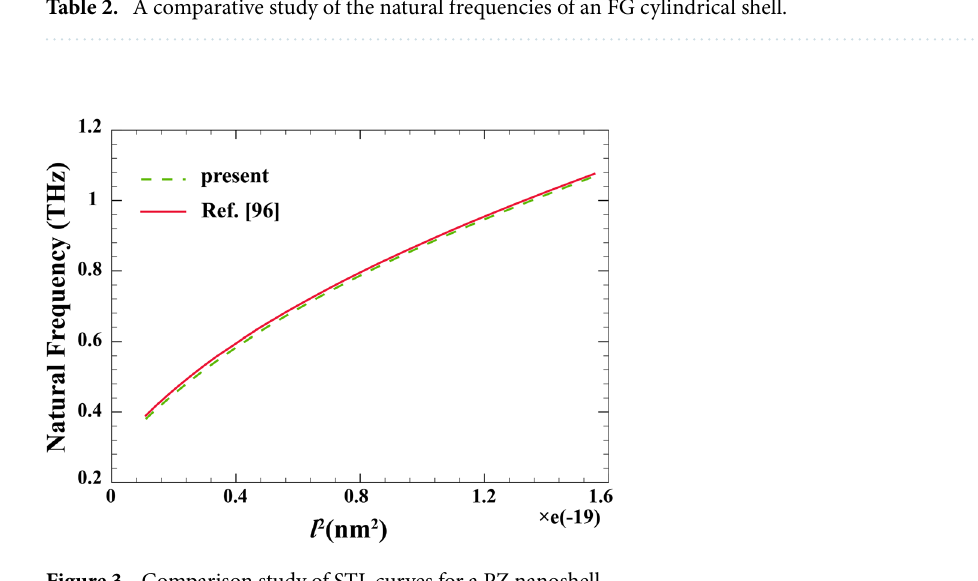
Table 2. A comparative study of the natural frequencies of an FG cylindrical shell.